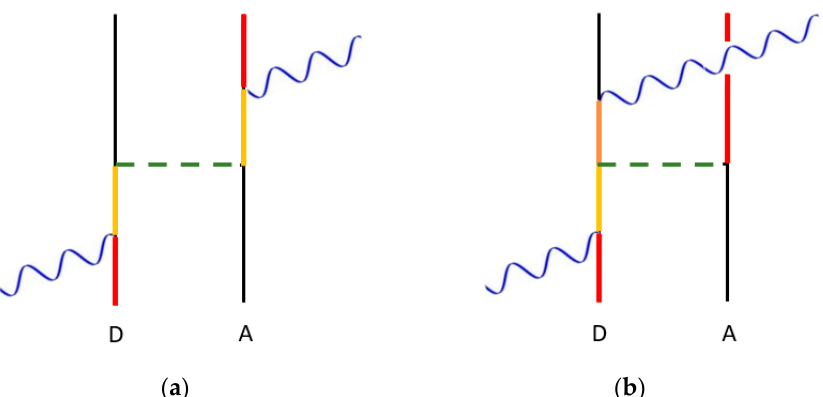
Figure 4. Representative near-zone graphs for calculating the matrix element for electronic energy transfer between a donor D and an acceptor A, under the influence of a throughput off-resonance laser beam: ( a ) contribution for transfer satisfying two-quantum selection rules at D and A; ( b ) contribution when the input beam is absorbed and emitted at D while it simultaneously interacts with A. Colour coding as in Figure 2; the orange line segment again indicates a virtual intermediate state, which need not be the same as for the yellow segment preceding it.